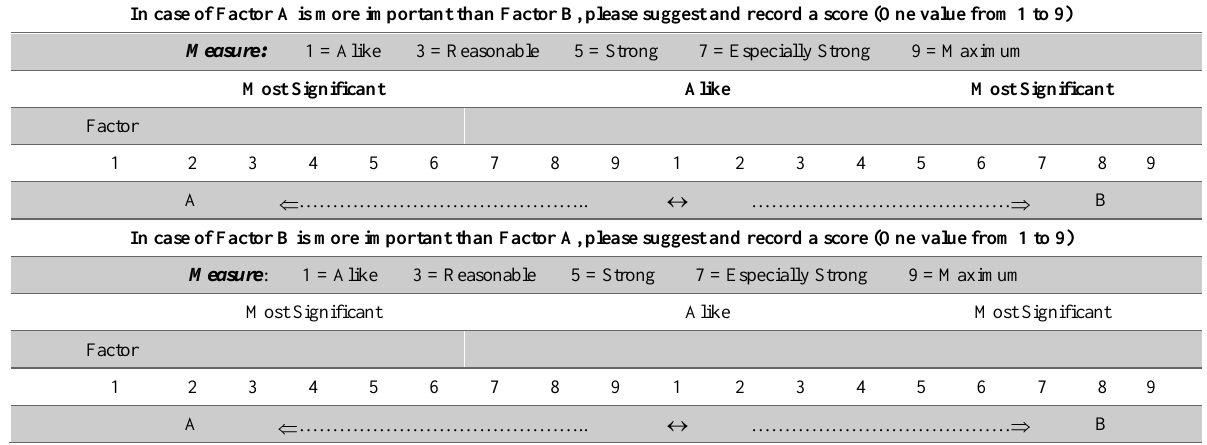
Table 6. Guideline: Expert Opinion and Recommendation in a Pairwise Evaluation of